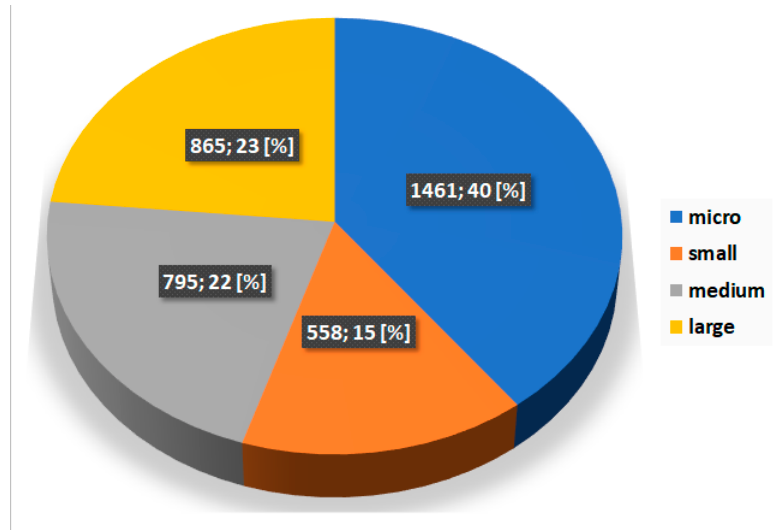
Figure 5. Structure of the number of businesses operating in the Podkarpackie Voivodeship by enterprise size. Source: own elaboration based on the data analyzed from 2018 (http://www.emis.com).